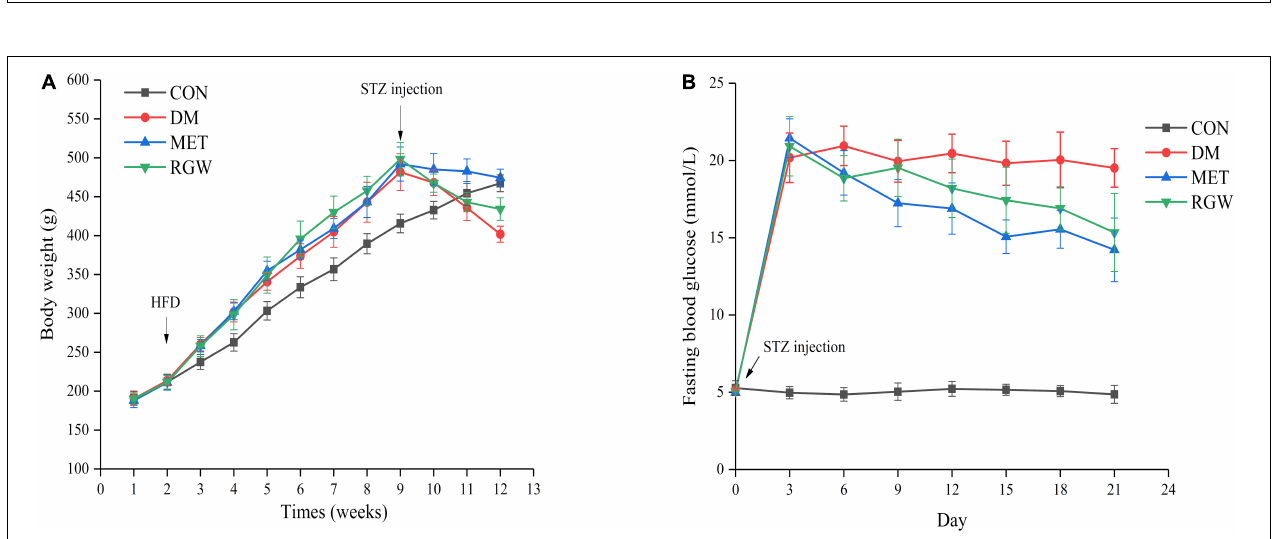
FIGURE 3 | Effects of RGW on body weight and fasting blood glucose in DM rats. (A) Body weight. (B) Fasting blood glucose. Data are expressed as mean ± SD ( n = 8).